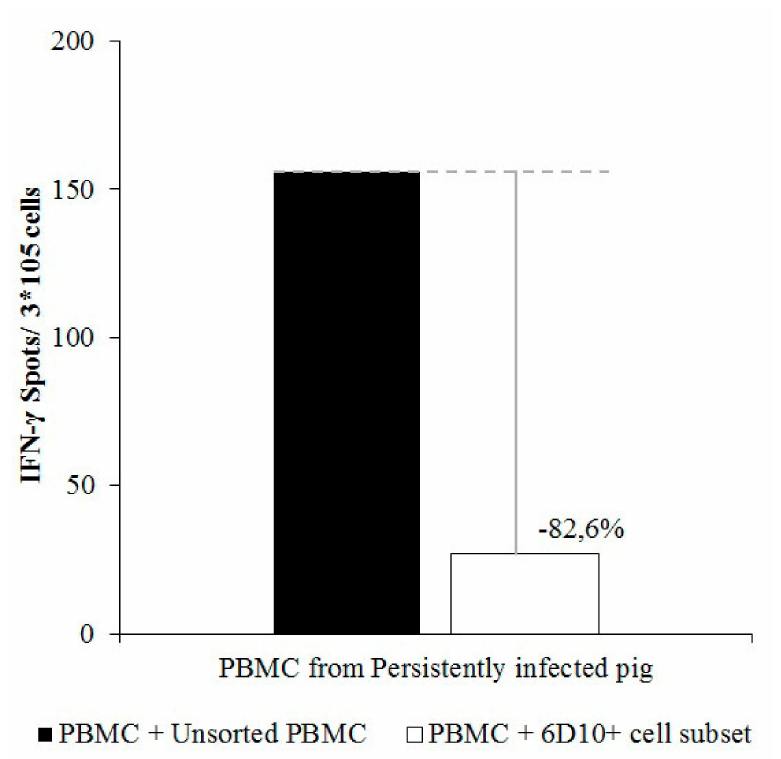
Figure 6. Reduction of the IFN- γ response by the granulocytic cell subset from PBMC of CSFV persistently infected animals. PBMCs from a CSFV-specific immune animal were co-cultured with unsorted (black bars) or sorted 6D10 + (white bars) cells from PBMC of a CSFV persistently infected pig in a 1:3 ratio and stimulated with CSFV Cat01 (MOI = 0.1). The x axis indicates the origin of